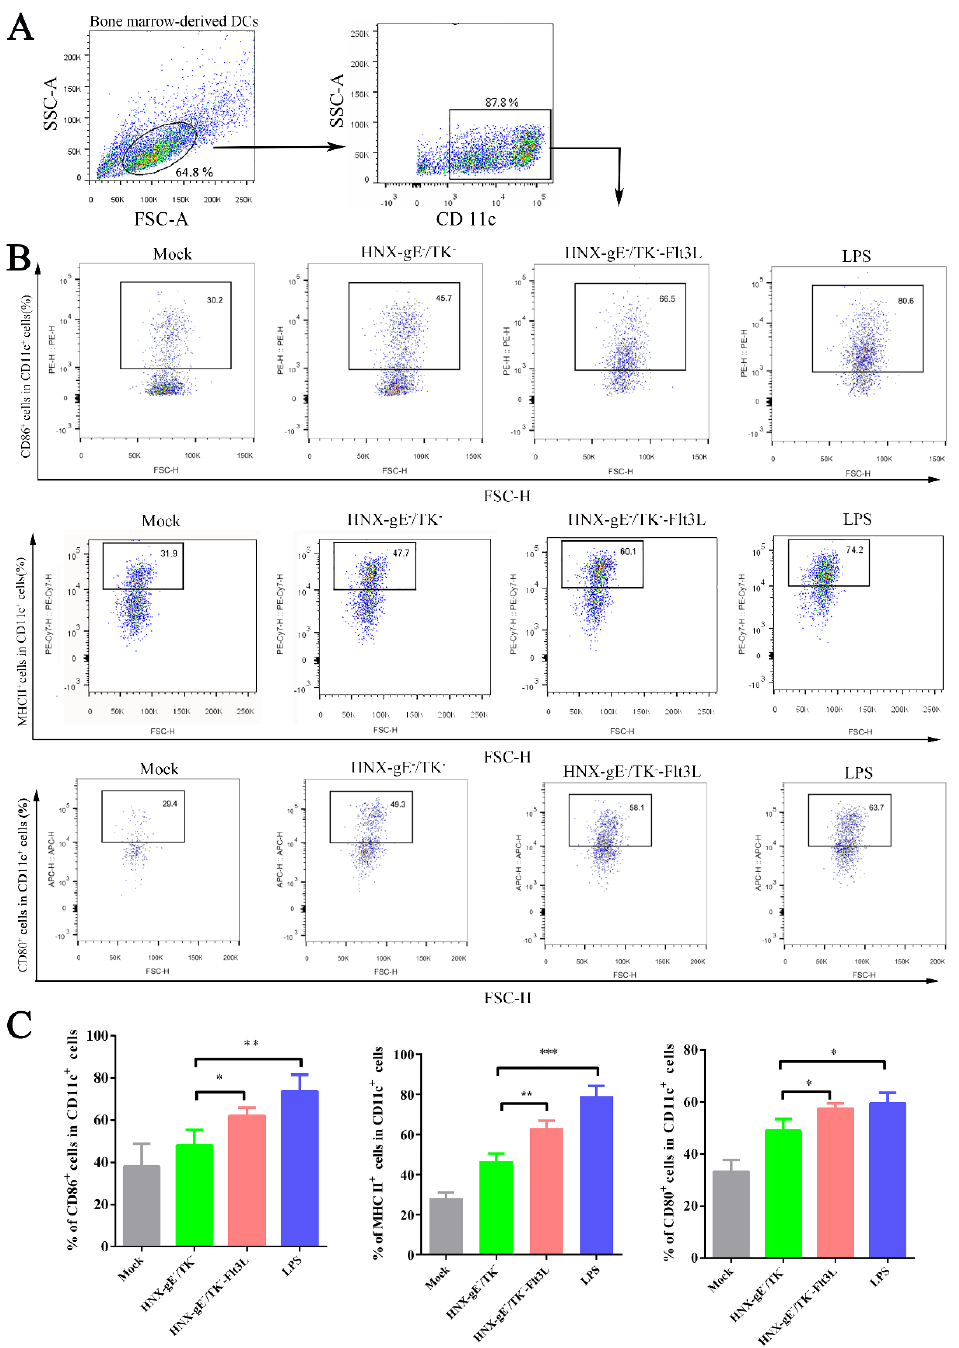
Figure 4. Activation of bone marrow-derived DCs by HNX-TK − /gE − -Flt3L in vitro. Bone marrow cells were harvested from BALB/c mice and maintained with GM-CSF and IL-4. LPS was used as a positive control, and the medium from untreated cells (mock) was used for negative controls. ( A ) Representative gating strategy for derived dendritic cells (DCs). ( B ) Representative flow cytometric plots of CD11c + - and CD86 + -activated DCs, CD11c + - and MHCII + -activated DCs, and CD11c + - and CD80 + -activated DCs. ( C ) Statistical results of DCs are summarized in the chart. The data are the means from three independent experiments (* p < 0.05; ** p < 0.01; and *** p < 0.005).